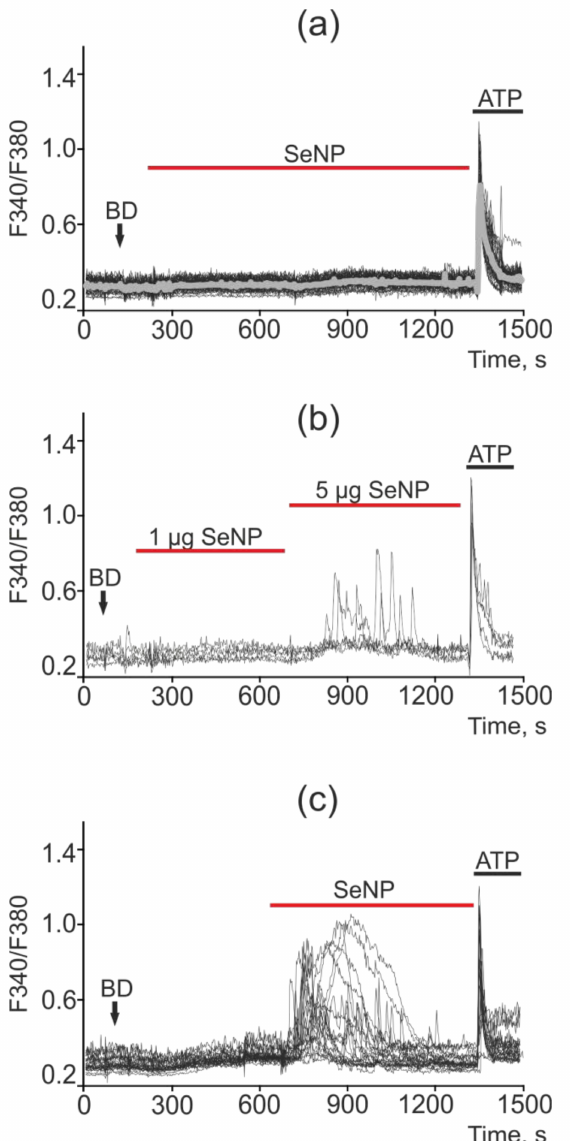
Figure 12. Ca 2+ signals in control MCF-7 cells ( a ) and in response to application of 1 µ g/mL and 5 µ g/mL ( b ) and 10 µ g/mL ( c ) SeNP. BD = application of bi-distilled water equivalent to the amount of SeNP solvent. At the end of the experiment, the Ca 2+ ionophore, Ionomycin (Iono, 1 µ M), or the purinoreceptor activator, ATP (10 µ M), was applied to normalize the [Ca 2+ ]i signal to the maximum. Typical Ca 2+ signals of cells are